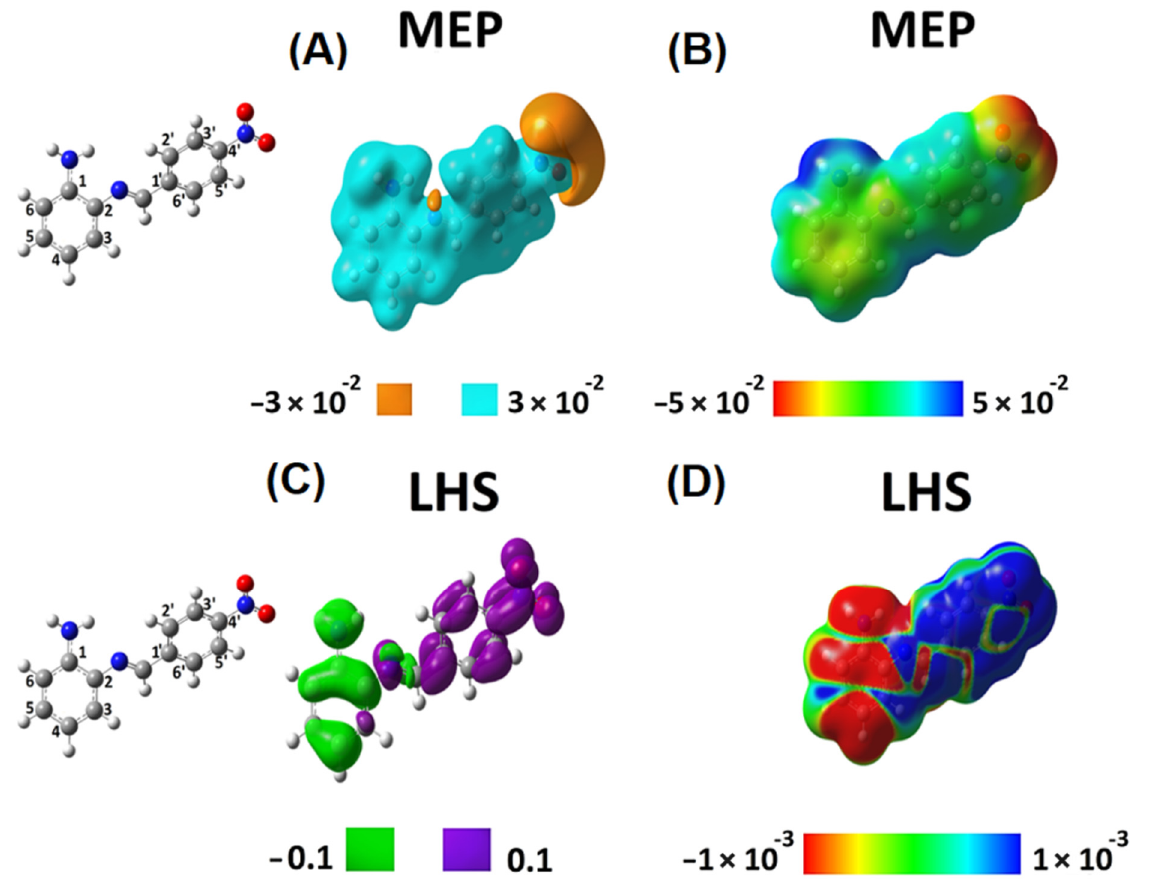
Figure 5. Local reactivity descriptors of SB-2. Molecular electrostatic potential (MEP) and local hyper softness (LHS) as 3D pictures. Isovalues of MEP are displayed at ± 0.03 hartree · e − 1 (or 0.03 a.u.) ( A ), and isovalues of LHS are displayed at ± 0.1 e 3 · hartree − 2 · bohr − 3 (or 0.1 a.u.) for LHS ( C ). Values of MEP and LHS projected onto at an electron density isosurface of 0.001 e · bohr − 3 ranging from − 0.05 to 0.05 hartree · e − 1 ( B ) and from − 0.001 to 0.001 e 3 · hartree − 2 · bohr − 3 ( D ), respectively. The corresponding atom numbering is shown on the left.